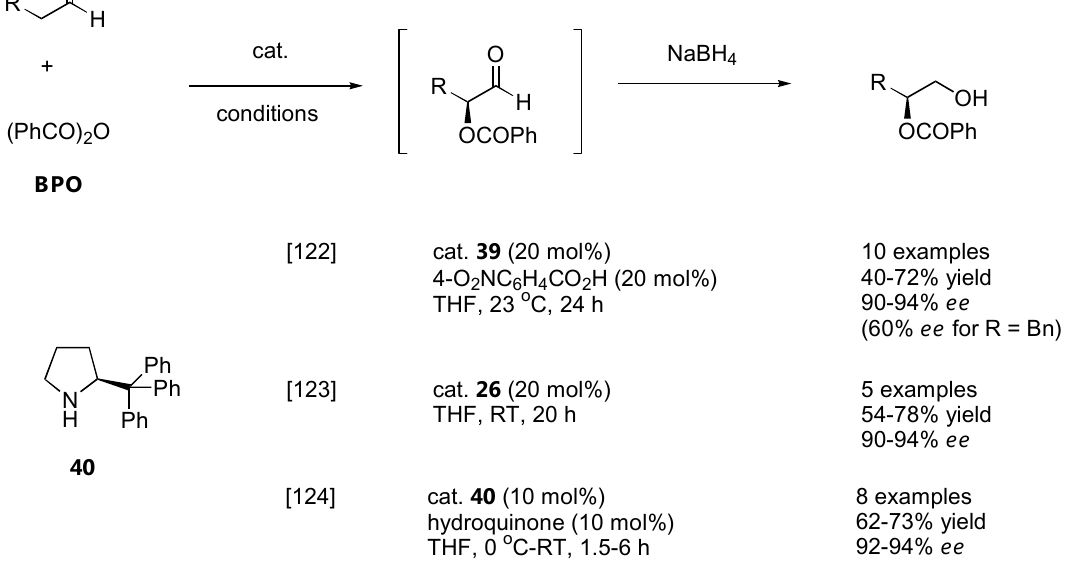
Figure 31. Organocatalyzed  -oxybenzoylation of aldehydes with benzoyl peroxide. O R H